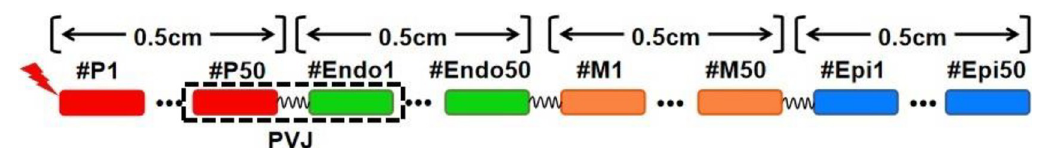
Fig 1. Model schematic of the one-dimensional (ID) Purkinje-ventricular system (PVS) tissue model. Tissue specific conduction velocities and the conduction delay across the Purkinje-ventricular junction (PVJ) were adjusted according to experimental measurements [19,